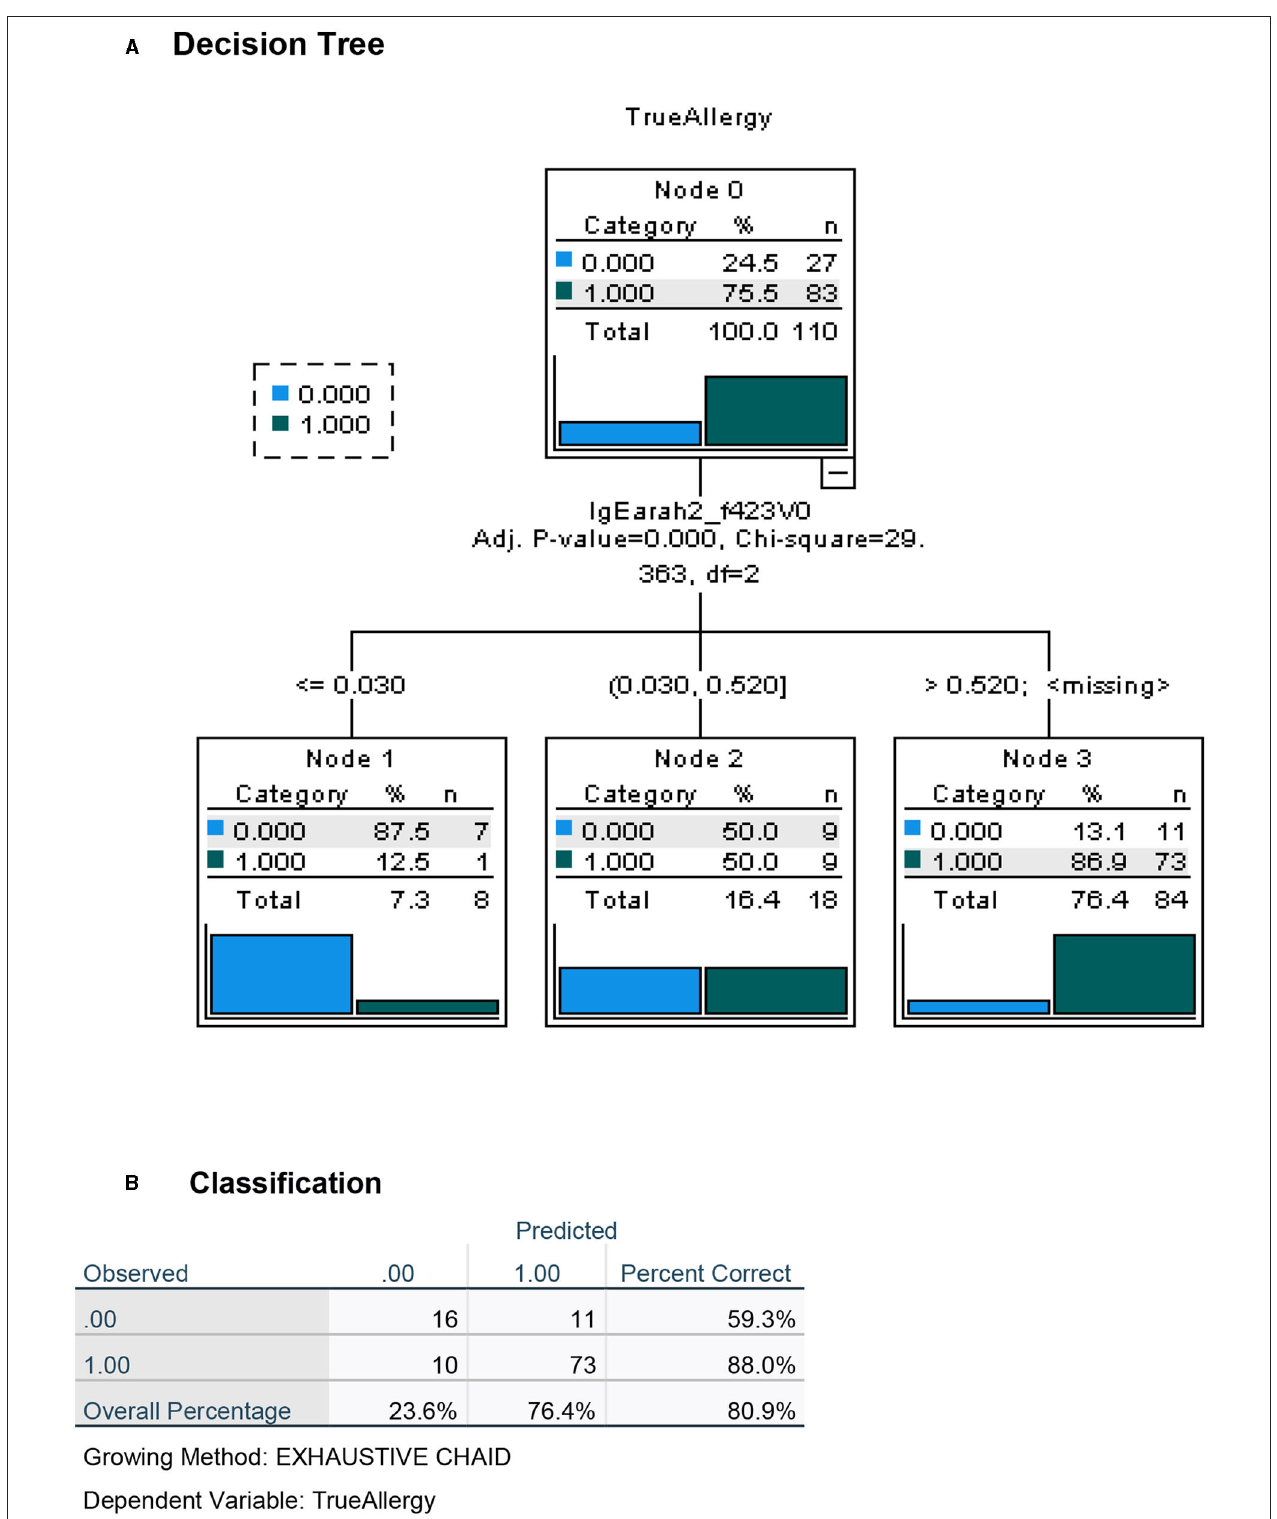
FIGURE 5 | Decision tree analysis for the apriori (before challenge) classification of Peanut Allergy (PA) and Peanut Tolerance (PT) in high risk preschoolers using all other laboratory results but excluding results of the LPP-MH prick tests. (A) Decision tree and (B) Classification table.